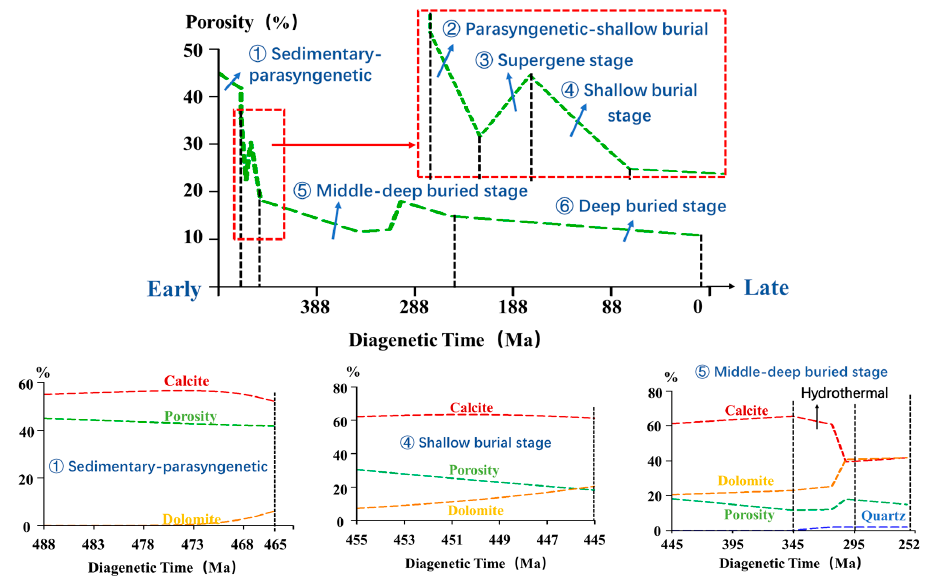
Figure 10. Porosity and typical mineral content evolution under seawater evaporation environment.